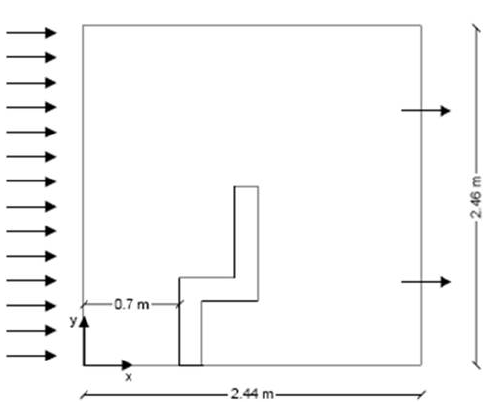
Figure 2. Roots of the body core temperature for different skin temperatures.